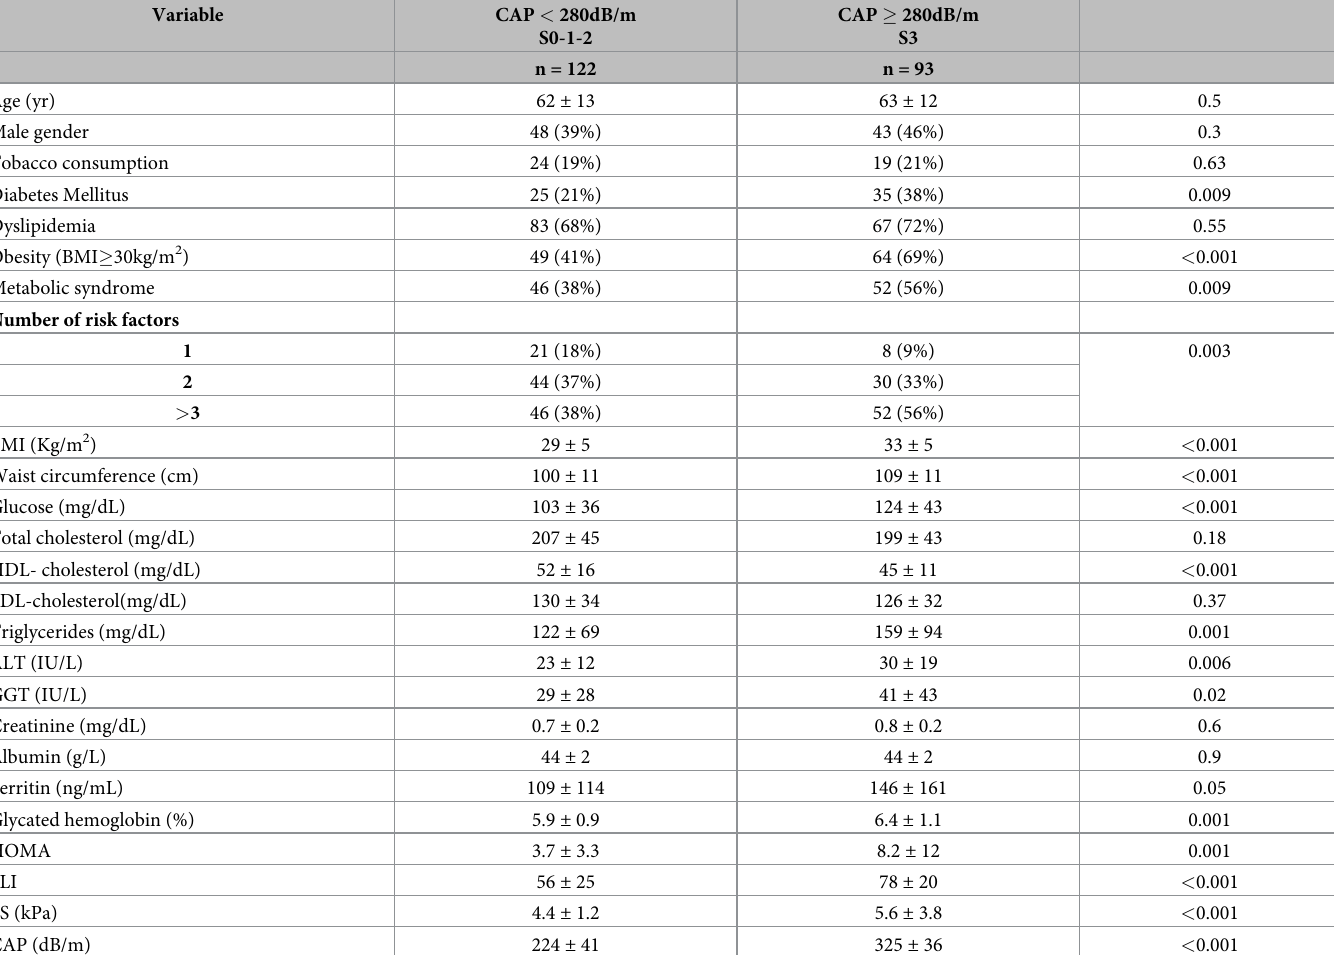
Table 5. Comparison of baseline characteristics of subjects with risk factors for NAFLD categorized according to the presence (S3) or absence (S0-1-2) of severe steatosis measured by CAP values.